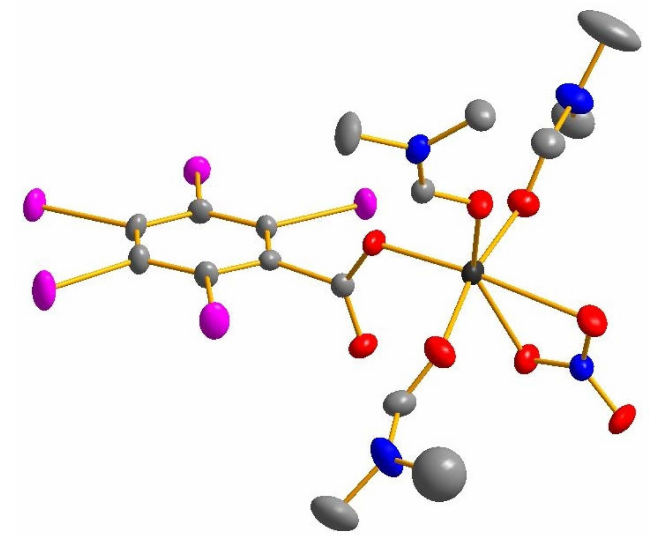
Figure 4. Structure of 2 (thermal ellipsoids, 50% probability).